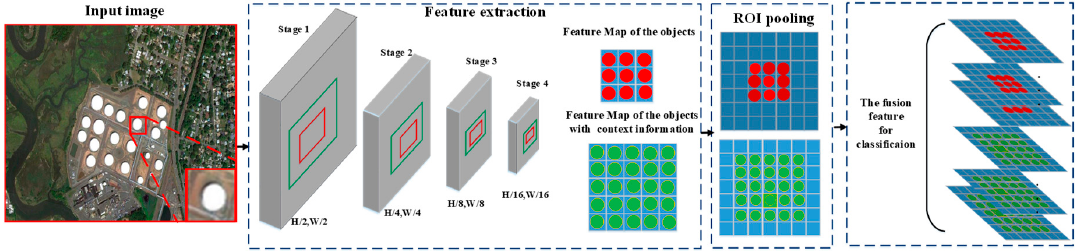
Figure 5. The feature fusion process with context information.